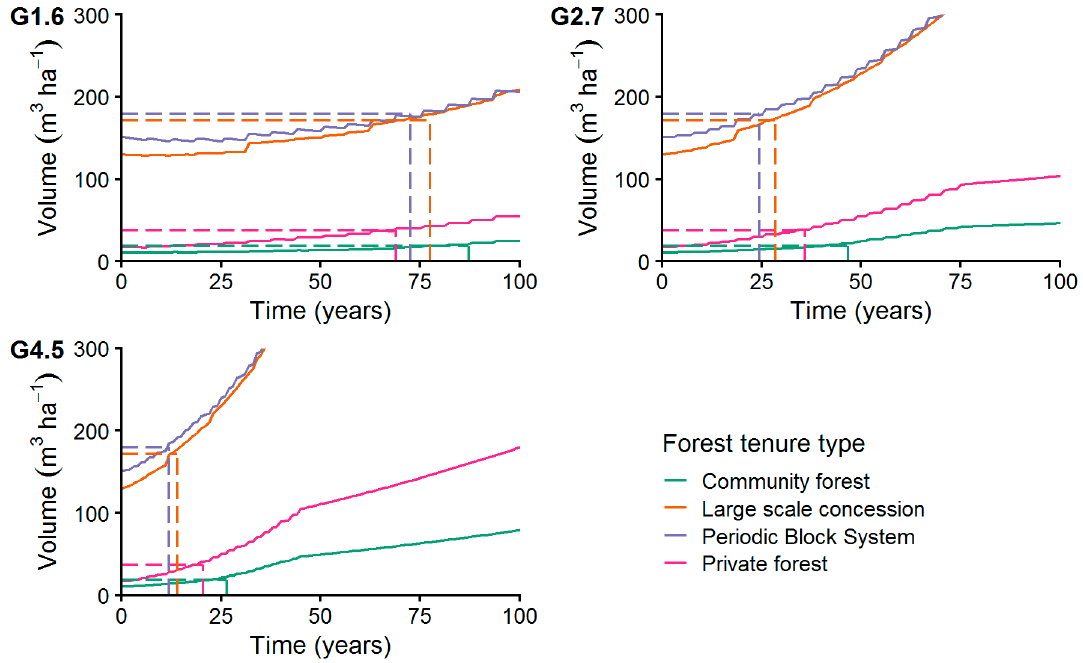
Figure 12. Increment of commercial species volume of trees with DBH ≥ 45 cm applying growth levels G1.6, G2.7, and G4.5 with MR = 1% p.a. The dashed lines connect the initial volume before harvesting with the years needed to achieve it after harvesting (recovery time, see Section